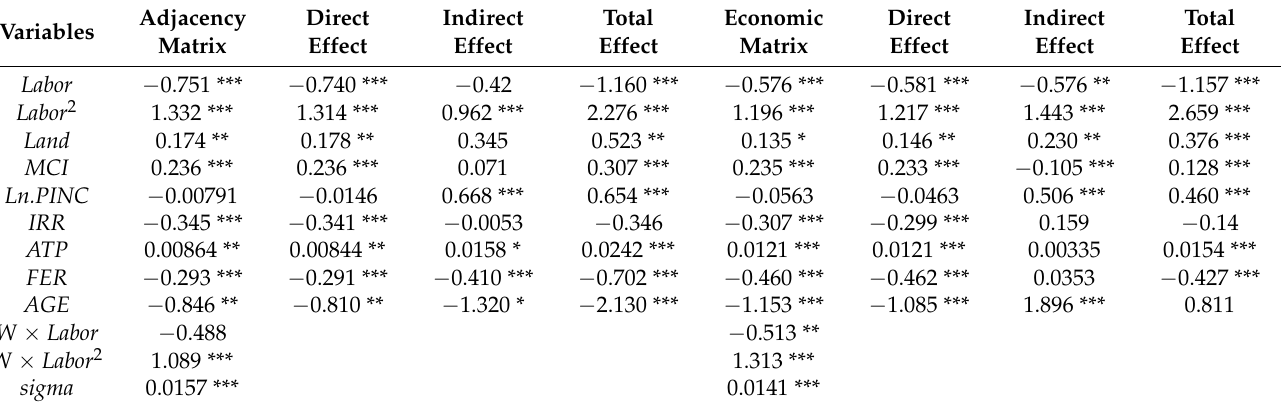
Table 5. A robustness test at the country